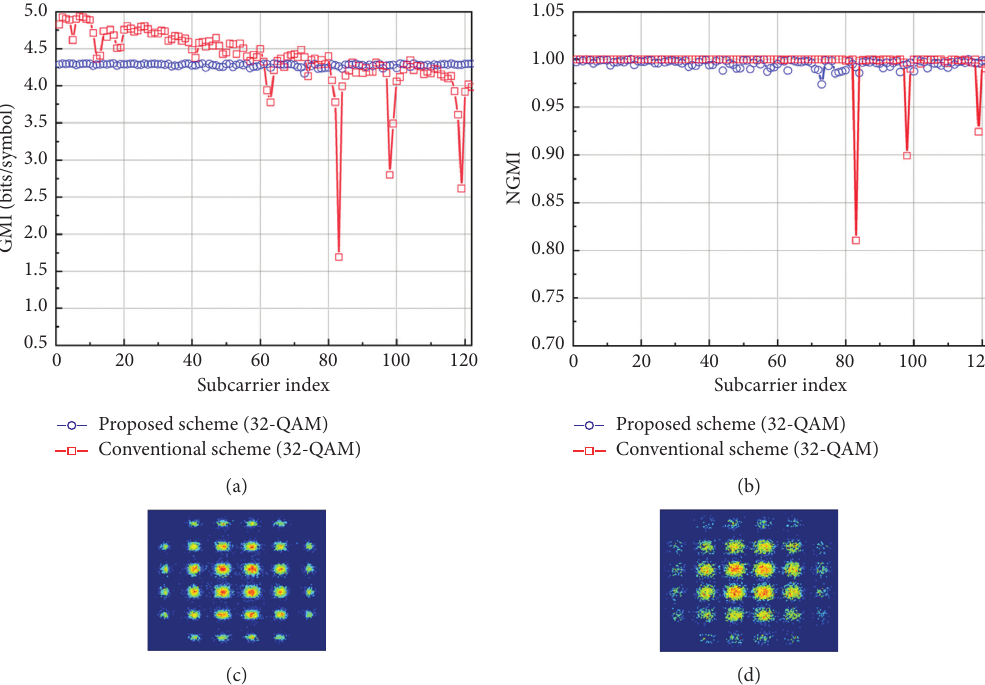
Figure 3: Experimental verification when the modulation order is 32-QAM: (a) GMI as a function of subcarrier index, (b) NGMI as a function of subcarrier index, (c) corresponding constellation density of the scheme without precoding, and (d) corresponding constellation density of the proposed scheme with OCT precoding.